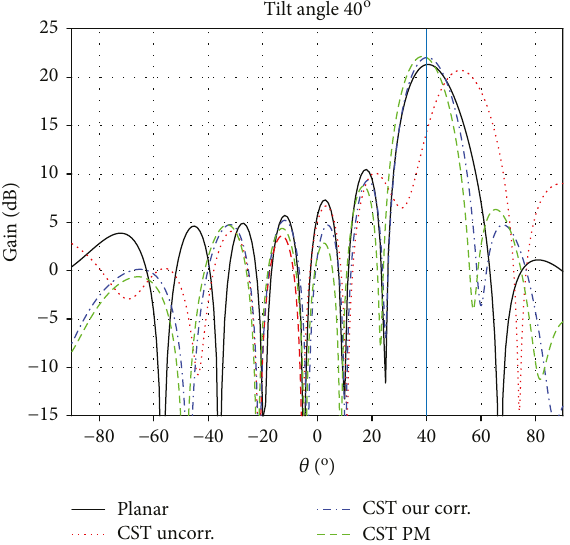
Figure 10: Simulated 8 × 8 antenna gain: planar, uncorrected, corrected with our approach, and corrected with the projection method patterns on the yz -plane for θ